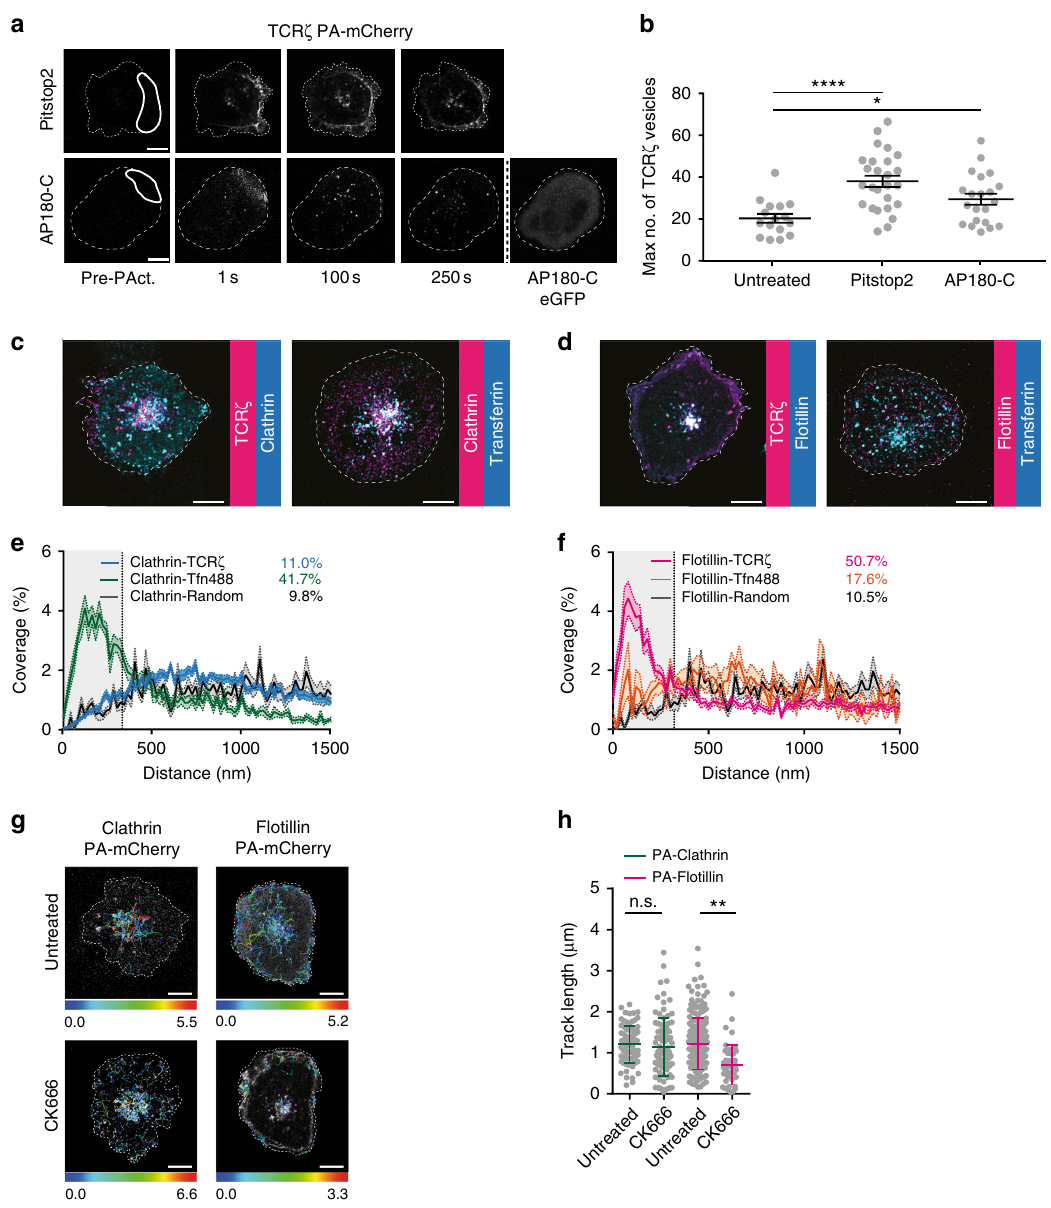
Fig. 2 TCR ζ is internalized through a clathrin-independent pathway in vesicles positive for fl otillin-2. a Representative images of activated Jurkat T cells expressing TCR ζ -PA-mCherry either pretreated with 6 µ M pitstop2 or co-expressing AP180-C-EGFP and activated and photoactivated as before. b Maximum number of PA-mCherry vesicles in cells treated with pitstop2 or co-expressing AP180-C-EGFP. c – f Representative images ( c and d ) and cross- channel nearest neighbor distance ( e and f ) between vesicles de fi ned by Clathrin-EGFP and TCR ζ -PA-mCherry or Clathrin-PA-mCherry and transferrin- Alexa488, and fl otillin-2-EGFP and TCR ζ -PA-mCherry or fl otillin-2-PA-mCherry and transferrin-Alexa488, in Jurkat T cells activated on anti-CD3 ε and anti-CD28-coated surfaces. Percentages shown are for vesicles having a distance of less than 320 nm to their nearest neighbor in the other channel. g Representative examples of Clathrin-PA-mCherry (left) or fl otillin-2-PA-mCherry (right) vesicle tracks detected in activated T cells untreated (top) or treated with CK666 (bottom). Color scale depicts length in µ m. h Length of vesicle tracks in vehicle-treated and CK666-treated cells. Each dot represents a single track. Scale bars, 5 µ m. Data obtained from three or more independent experiments. Small horizontal lines indicate mean (±SEM). ns, not signi fi cant; ** p < 0.001; **** p < 0.00001; Mann – Whitney t